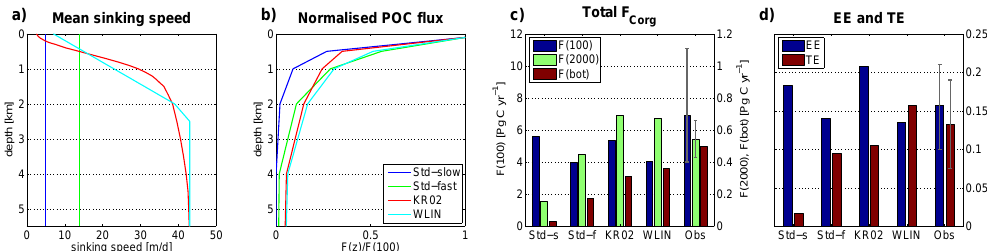
Figure 23. (a) Mean profiles of sinking speed with depth for the four experiments STD-slow (dark blue), STD-fast (green), KR02 (red), and WLIN (light blue); (b) as panel (a) , but for mean profiles of POC fluxes (averaged over areas with water depth > 4000m) normalised to the flux at 100m depth; (c) globally accumulated fluxes of particulate organic carbon (POC) at 100m depth (dark blue), at 2000m depth (green), and the downward POC flux at the ocean bottom for depths larger than 1000m (brown); (d) export efficiency (EE, dark blue) and transfer efficiency (TE, brown). The observation-based estimates (“Obs”) in panels (c) and (d) are derived from Henson et al. (2012), Honjo et al. (2008), and Laws et al. (2000) for POC flux at 100m and EE, from Henson et al. (2012) and Honjo et al. (2008) for POC flux at 2000m and TE, and from Seiter et al. (2005) for the bottom POC flux. The coloured bars indicate the mean of the observation-based estimates, while the grey error bars give the maximum and minimum estimates. Note that the Honjo et al. (2008) EE and TE are calculated as ratios of total PP, total export, and total flux at 2000m, and not as the mean of gridded EE and TE values as the rest of the values presented here. We include these data nevertheless since the differences between the two methods of calculation are small compared to the spread of the observation-based